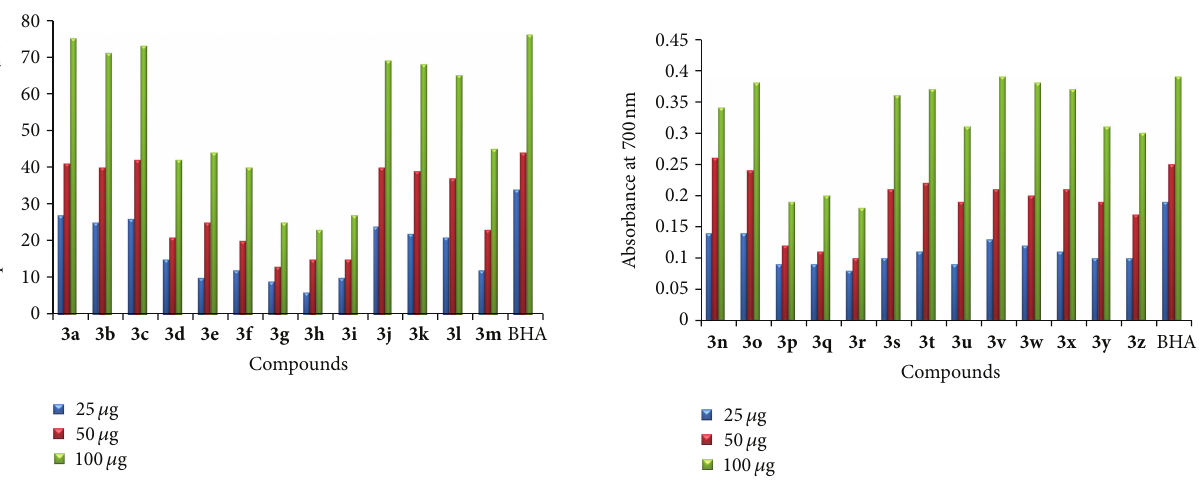
Figure 3: Total antioxidant capacity of 3a – m .